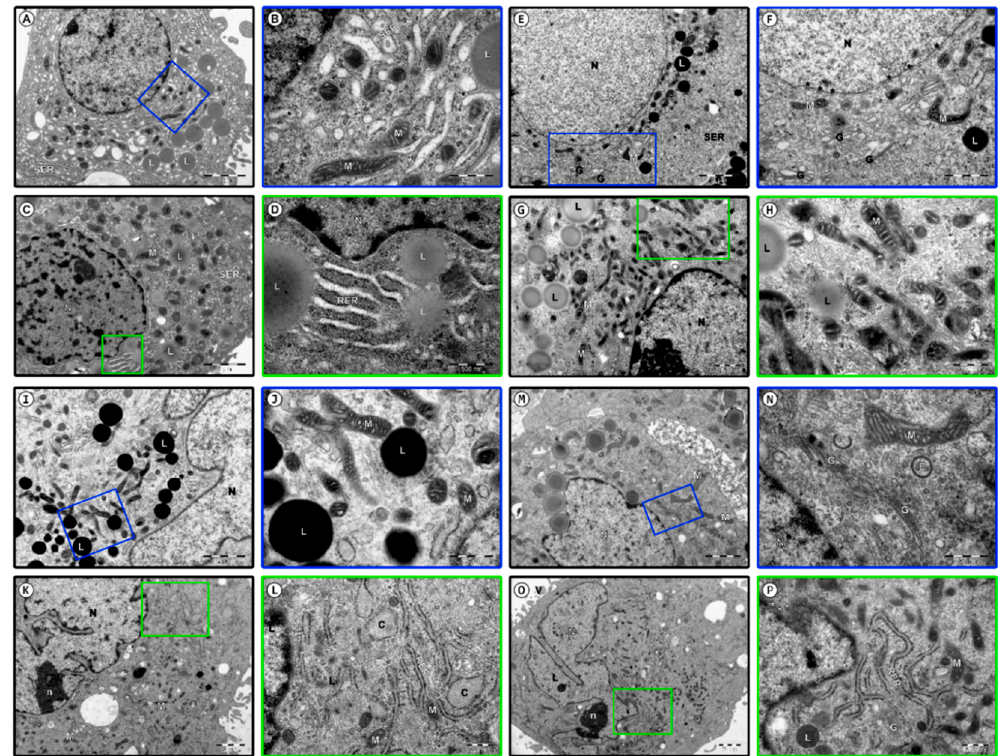
Figure 5. Photomicrographs of human ovarian granulosa cells during long-term culture. Day 1 ( A – D ); Day 7 ( E – H ); Day 15 ( I – L ); Day 30 ( M – P ); nucleus ( N ) , pores in the nuclear membrane ( * ), smooth endoplasmic reticulum ( SER ), mitochondria ( M ), lipid vacuoles ( L ), rough endoplasmic reticulum ( RER ), topical widenings ( C ), Golgi apparatus ( G ), endosomes ( E ), multivesicular bodies ( X ), microvilli ( V ), nucleolus ( N ).